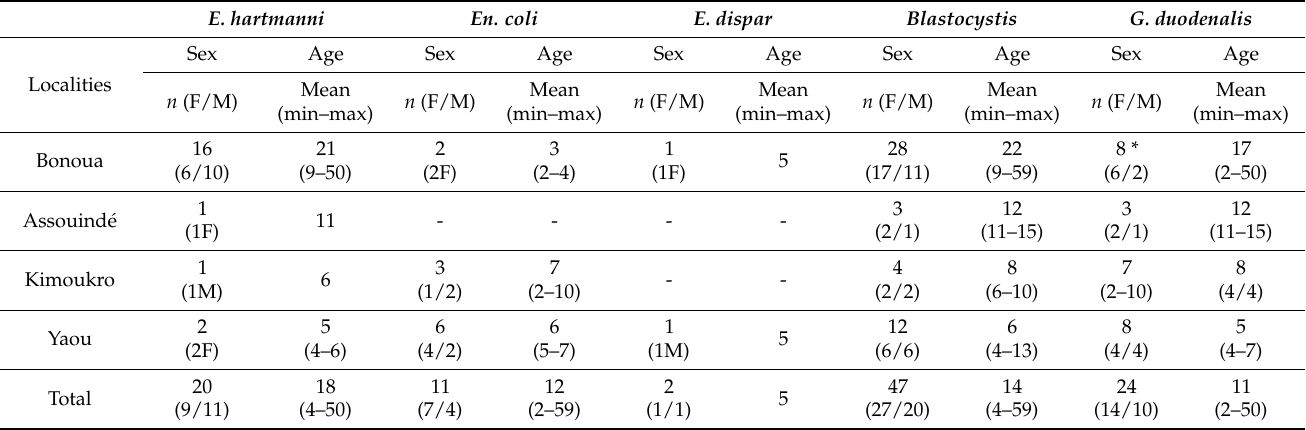
Table 3. Protozoa distribution based on age and